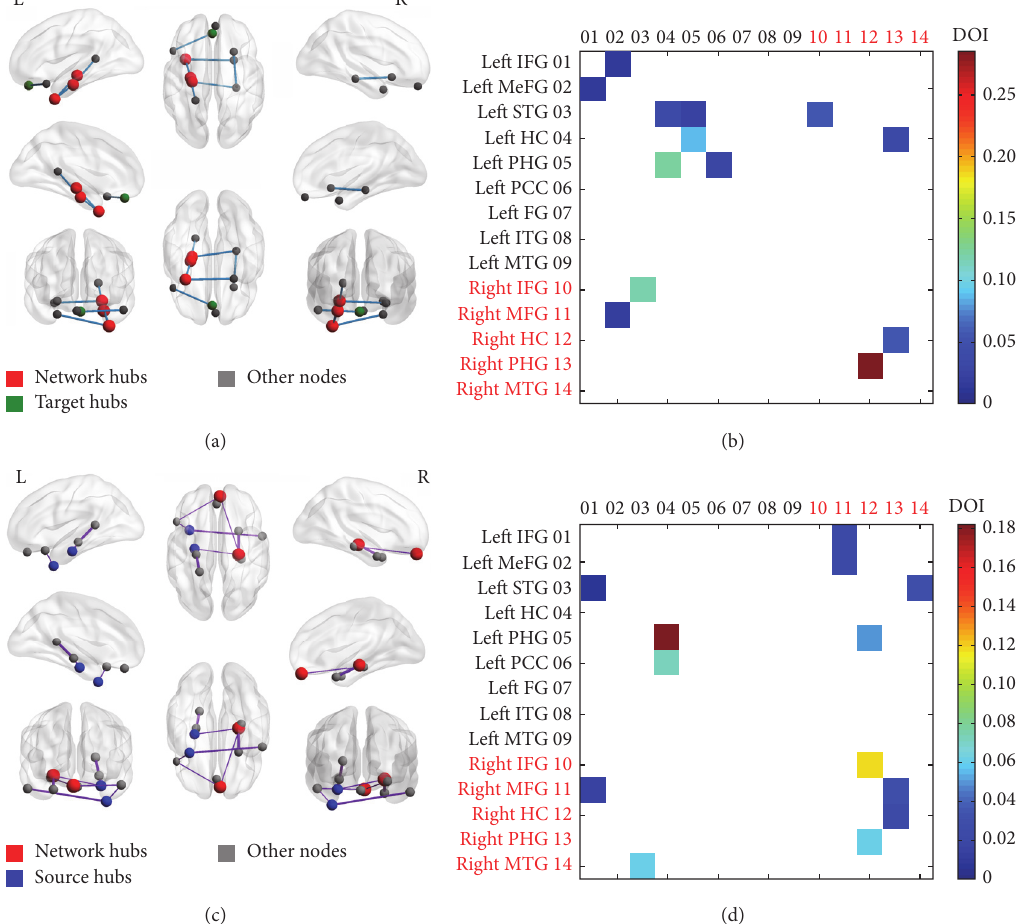
Figure 2: Causal influence of effectively connected episodic memory network in normal controls and mTBI survivors. (i) Connection density in normal controls and mTBI was not significantly different; (ii) significant causal interaction mainly existed between ROIs in the left hemisphere in normal controls, while mTBI survivors presented significant cross-hemisphere connection originating from the right hemisphere; (iii) nodes of source hubs (flow-out hubs), target hubs (flow-in hubs), and network hubs were displayed by different colors, but only the network hub color was presented if their function overlapped (a, c); (iv) significant causal interactions from nodes in 𝑥 -axis to nodes in 𝑦 -axis among all possible causal interactions were presented in (b, d); (v) relative strengths of path weights (in arbitrary units) were indicated by the width of lines; (vi) IFG:inferior frontal gyrus; MeFG: medial frontal gyrus; MTG-middle temporal gyrus; ITG: inferior temporal gyrus; STG-: superior temporal gyrus; FG: fusiform; HC: hippocampus; PHG: parahippocampal gyrus; ACC: anterior cingulate cortex; PCC: posterior cingulate